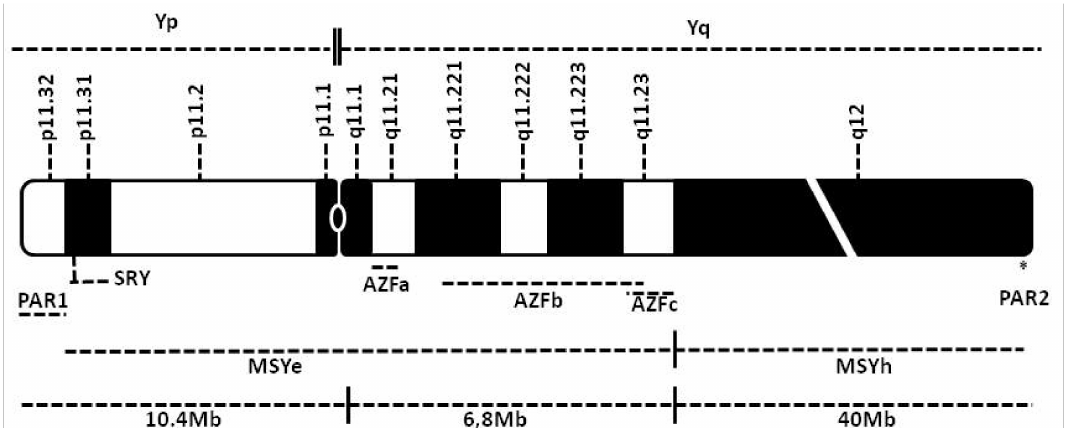
Figure 1. Overview of the Y chromosome organization. Rows from the top: (1) Short (Yp) and long (Yq) arms of the Y chromosome; (2) numbered cytogenetic bands; (3) chromosome banding according to the US National Library of Medicine, retrieved on October 25, 2018, at https: // ghr.nlm.nih.gov / chromosome / Y#idiogram (note: The region q12 is shortened (white cut), due to its large extension compared to the rest of the chromosome); (4) localization of the SRY gene, of the PAR regions (PAR2 is indicated by an asterisk, due to its small size) and of the AZF regions; (5) extension of the euchromatic (MSYe) and heterochromatic (MSYh) portions of the MSY region; (6) approximate length in megabases (millions of base pairs, Mb) of the short arm, euchromatic portion of the long arm and heterocromatic portion of the long